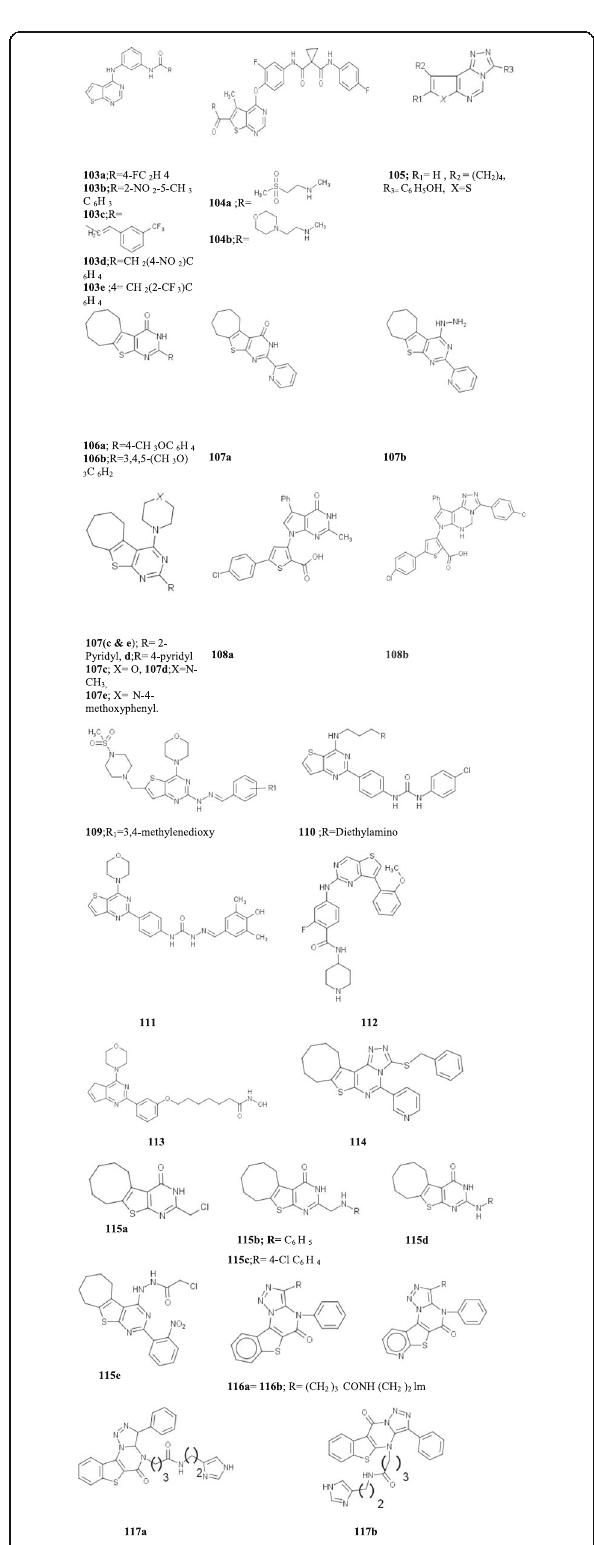
Fig. 36 Chemical structures of theinopyrimidine